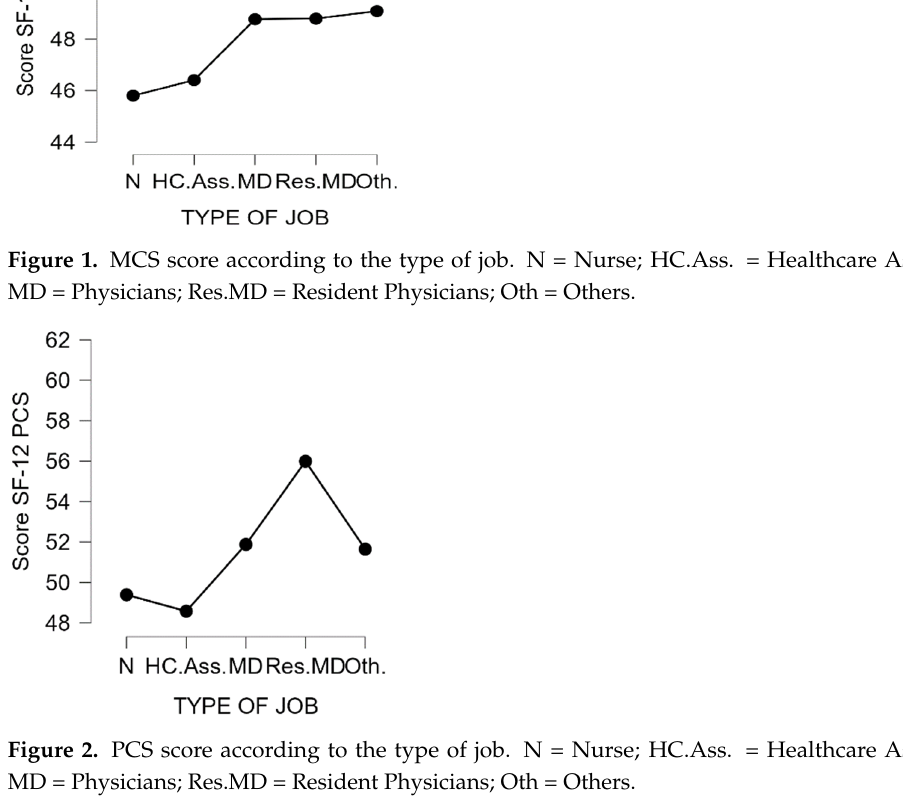
Table 5. Distribution of SF-12 PCS and MCS according to sex and professional sub-groups.